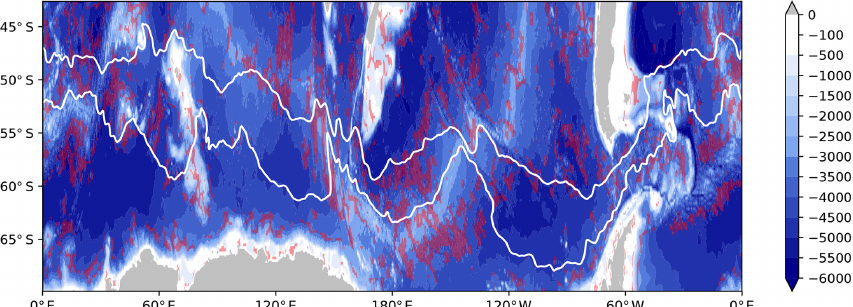
Figure 1. Topography (m) of the Southern Ocean from ETOPO2 (National Geophysical Data Center, NOAA). The red dashed areas indicate areas with a topographic roughness (computed as the variance in the topography over an area of 100km × 100km as in Wu et al., 2011) between 3 × 10 4 and 10 5 m 2 . The main pathway of the ACC is identified by two isocontours (0.4 and 1m) of mean dynamical topography from